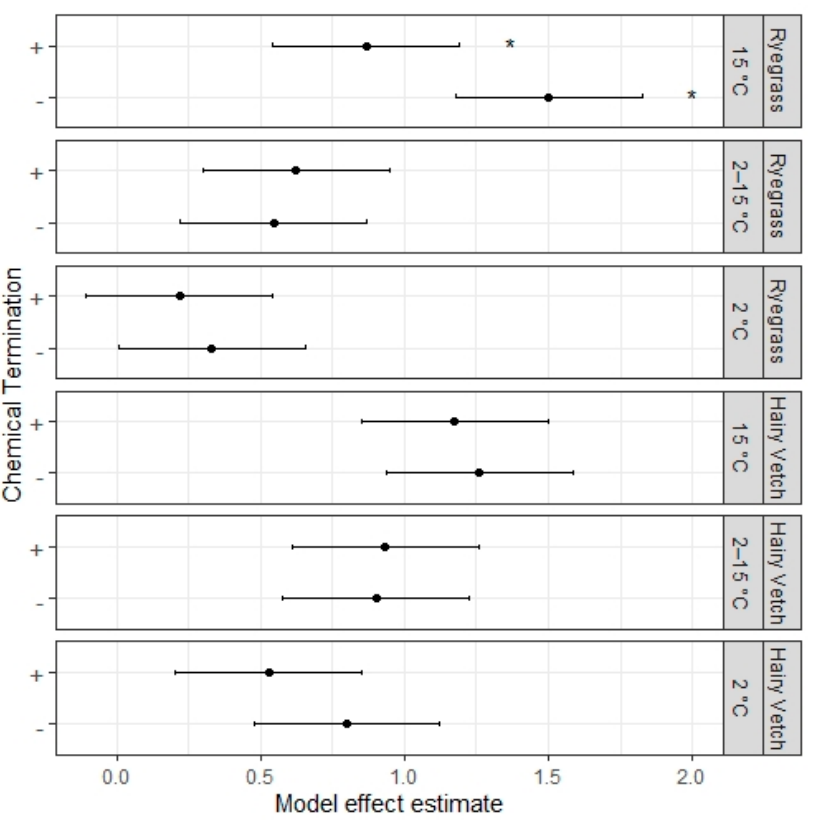
Figure 4. Post hoc comparison of linear model estimates, including main effects for net mineralized plant residue N between chemically terminated (+) and untreated ( − ) hairy vetch and ryegrass. The error bars represent 95% confidence intervals. Asterisks (*) denote a significant difference only within plant–temperature combinations.